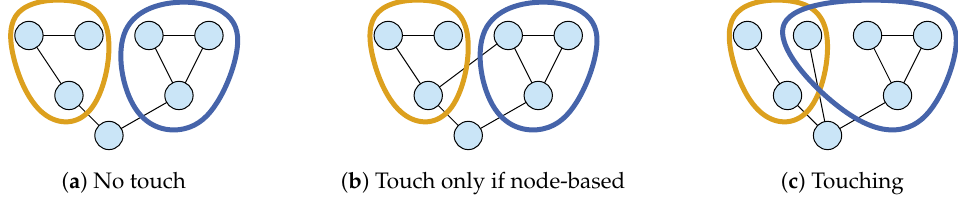
Figure 3. Illustration of the touch relation. The blue and orange sets depict